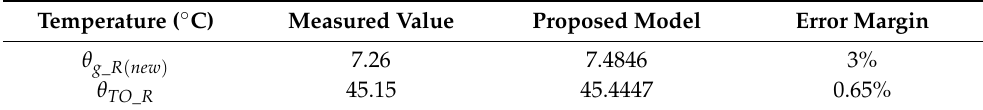
Table 9. Case Study 2: 10 MVA 22/11 kV distribution transformer.